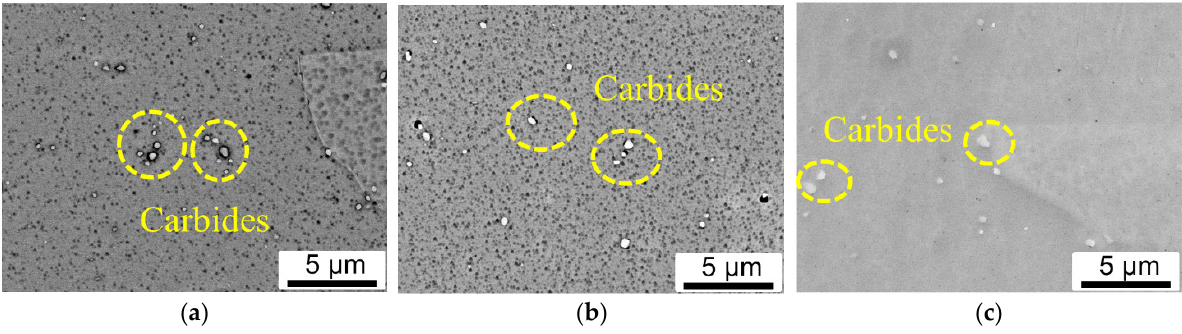
Figure 2. SEM-BSE (Back Scatter Electron) micrographs showing the phase evolution: ( a ) HA-1080 °C, ( b ) HA-1180 °C and ( c ) HIP-DA.